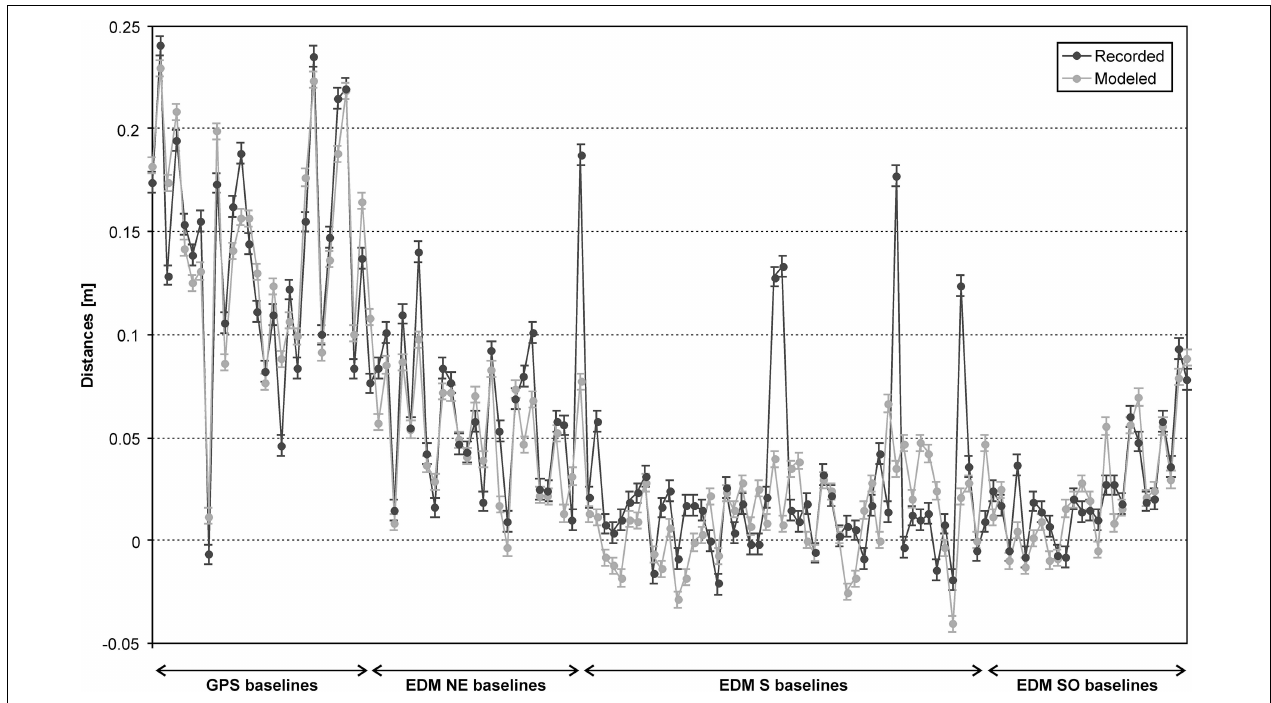
FIGURE 5 | Comparison between recorded (dark gray) and modeled (light gray) baseline changes (m) for the 1993–1998 sub-interval (C4 in Table 2